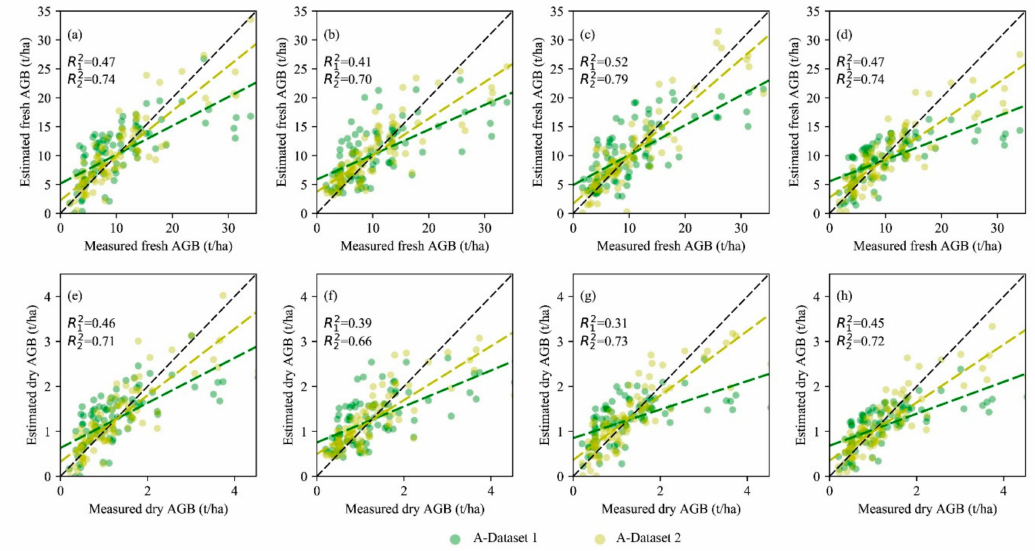
Figure 12. Comparisons of measured AGB and estimated AGB of maize via four methods based on A-Dataset 1 (green spots) and A-Dataset 2 (yellow spots) that were derived from the spectral data and fusion data, respectively: ( a – d ) OLS, RF, BP, and SVM for the AGB estimation of fresh maize; ( e – h ) OLS, RF, BP, and SVM for the AGB estimation of dry maize. R 12 and R 22 represent the coe ffi cient of determination for a linear regression model between the measured and estimated AGB using A-Dataset 1 and A-Dataset 2, respectively.